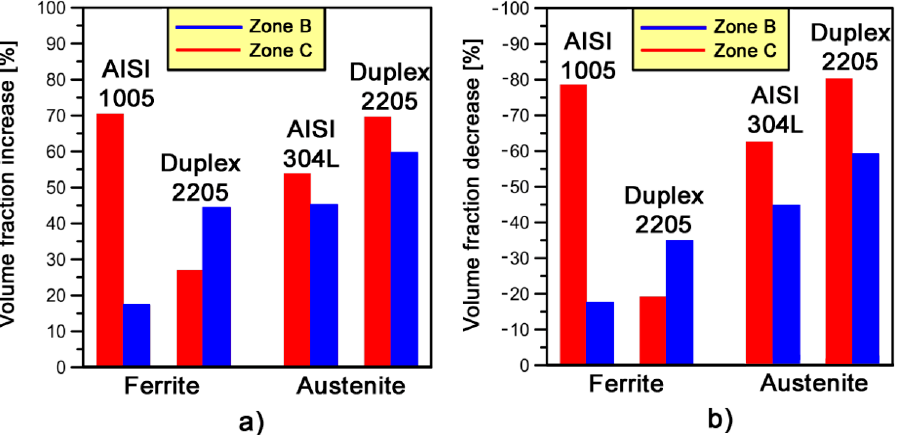
Figure 9. ( a ) LABs volume fractions increase; and ( b ) HABs volume fractions decrease on zones B and C for both phases.